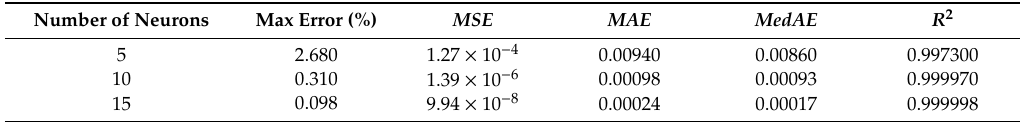
Table 2. Summary of model quality assessment for various hidden layer